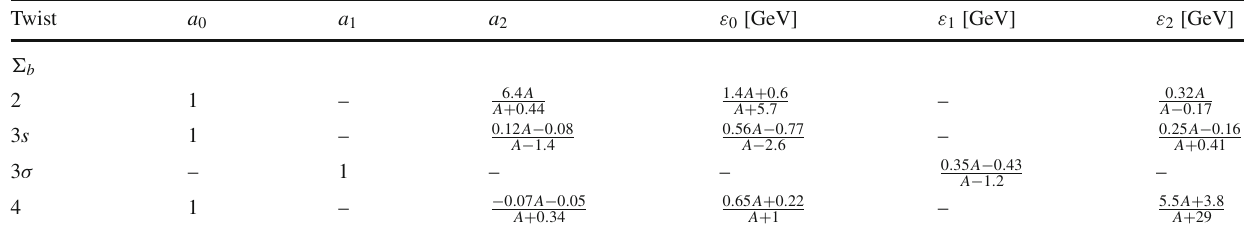
Table 2 Parameters for the parallel LCDAs of (cid:3) b in Eqs. (10). A replacement A → 1 − A is made for transversal LCDAs [38]. 2, 3 σ , 3s and 4 are twist